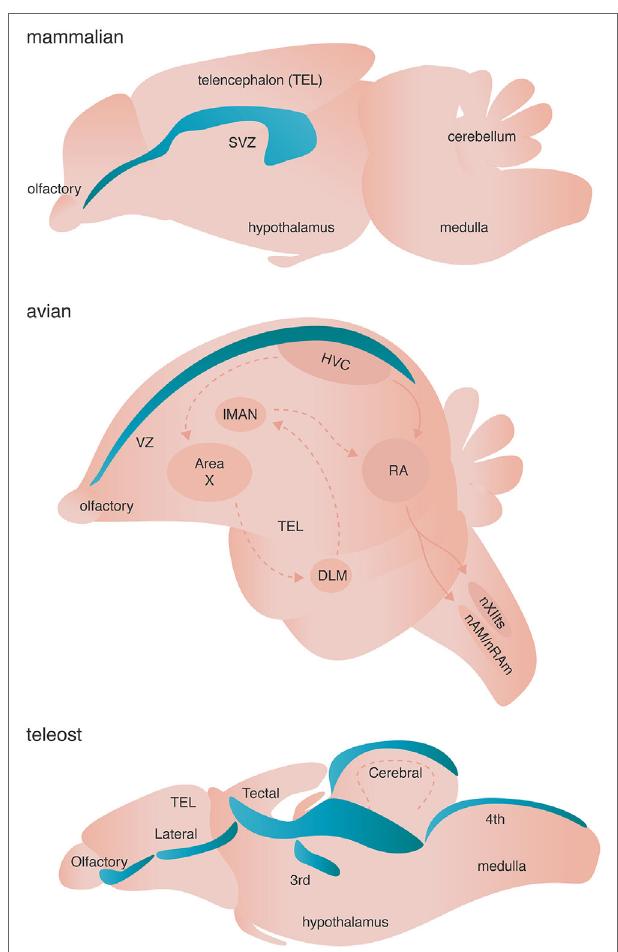
FiGURe 3 | Neurogenic niches in mammals, songbirds, and teleost fishes. Niches are colored blue. Dashed arrows in the avian brain represent the anterior forebrain pathway responsible for song learning, whereas solid arrows in the avian schematic represent the song motor pathway of songbirds. Both pathways are simplified for